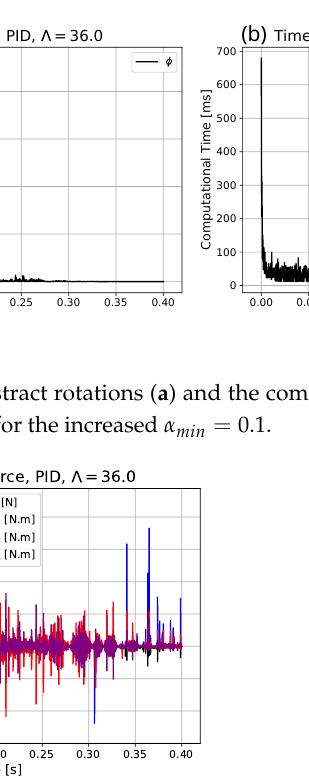
Figure 20. The adaptive control forces without force limitation for the increased α min = 0.1. ( a ) In full scale. ( b ) Without the initial “transient”.